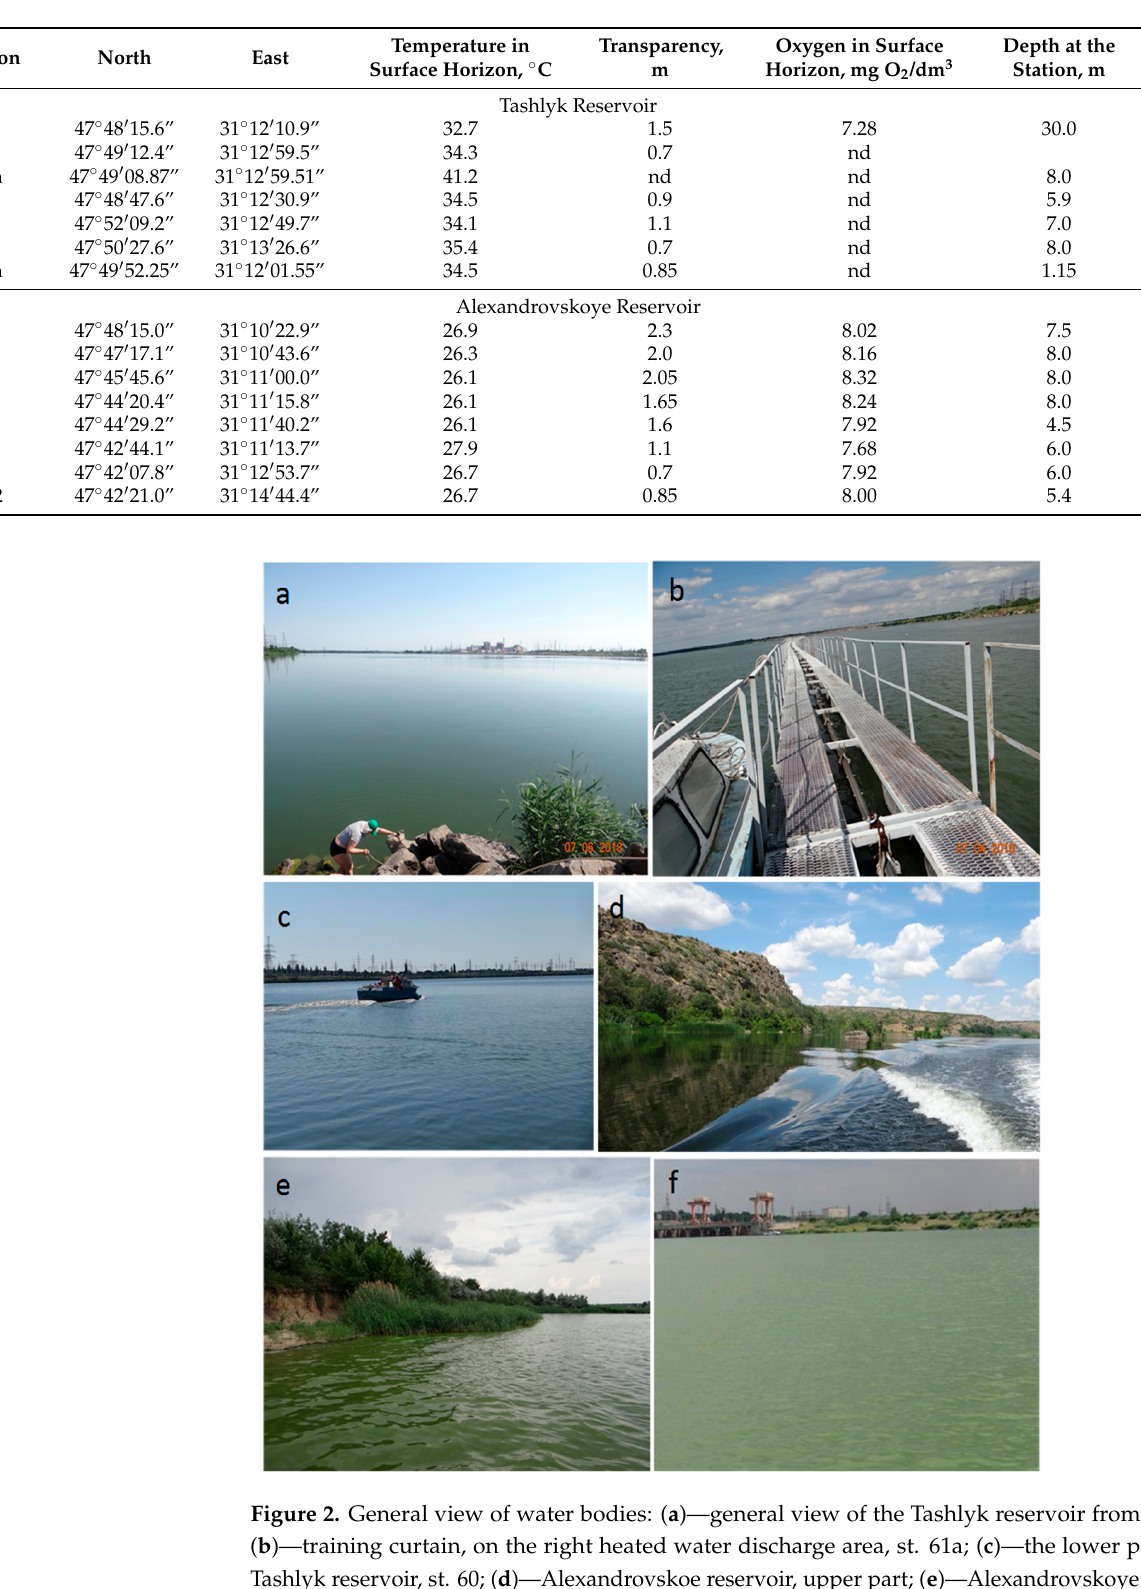
Table 1. Data on temperature, transparency, depth of the reservoir at the stations with coordinates, oxygen content and pH at stations taking hydrobiological samples (see Figures 1 and 2). “nd” is not determined.